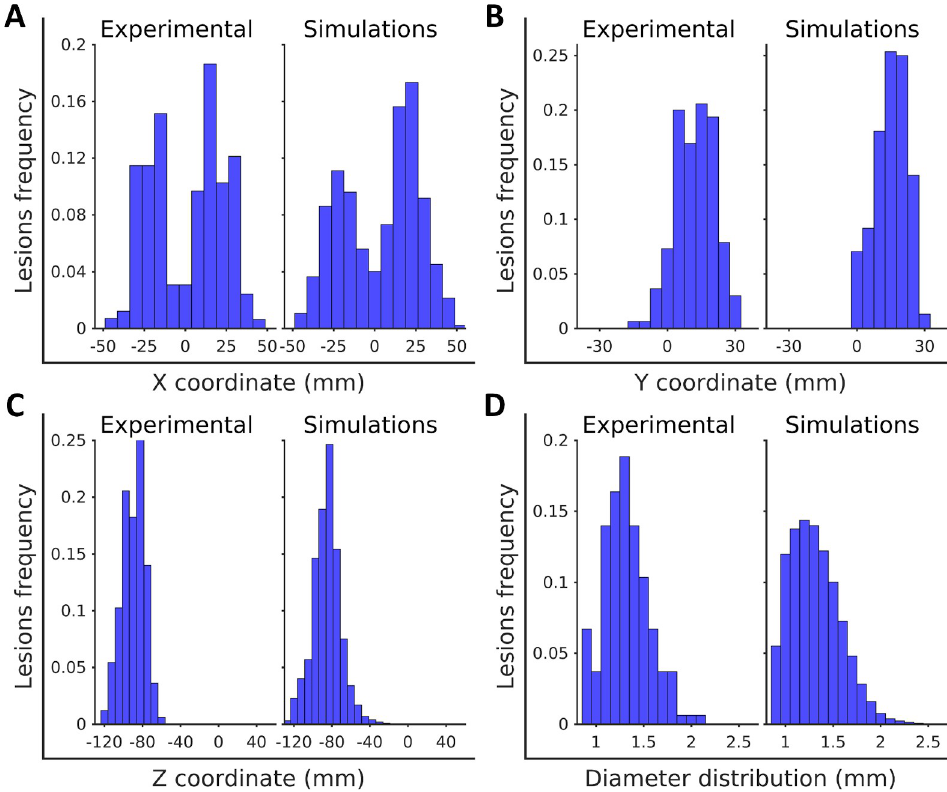
Fig 9. Comparison of experimental and computationally obtained distributions of lesion location and size. Computational distributions were obtained considering as initial infection one lesion in the mass centre of the observed lesions. The set of parameters used is: ρ = 0.13 day -1 , β = 0.08 mm -1 , and r max = 0.68 mm. (A) Coordinate X (Left— Right) histogram comparison. (B) Coordinate Y (Anterior–Posterior) histogram comparison. (C) Coordinate Z (Vertical) histogram comparison. (D) Diameter distribution histogram